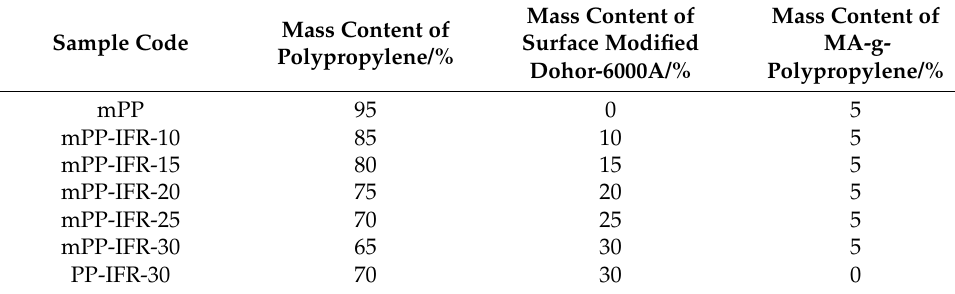
Table 1. The formulation and name of the